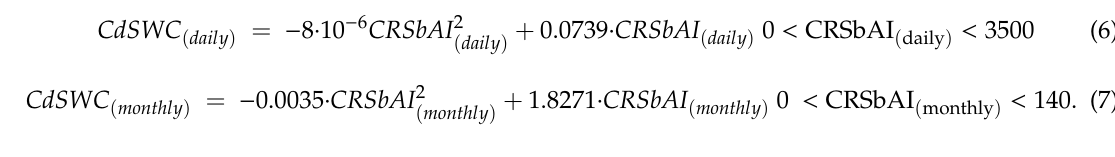
Table 1. The CdSWC to August calculated from the CRSbAI and Equations (6) and (7) with the ∆ NDVI (August minus March) in Bayan-Unjuul from 2017 to 2019. CRSbAI CRSbAI CdSWC (mm) CdSWC (mm) ∆ N DVI (Daily) (Monthly) (Daily) (Monthly) 2017 0.219 794 39 54 66 2018 0.279 1549 68 95 108 0.281 1302